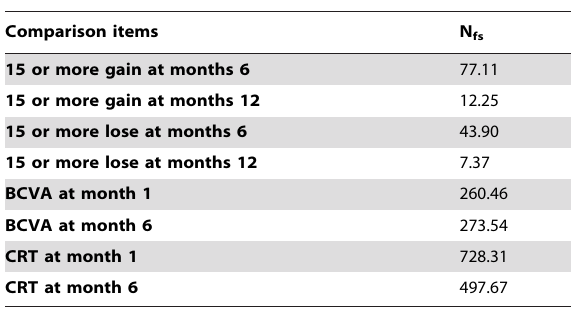
Table 4. False-safe